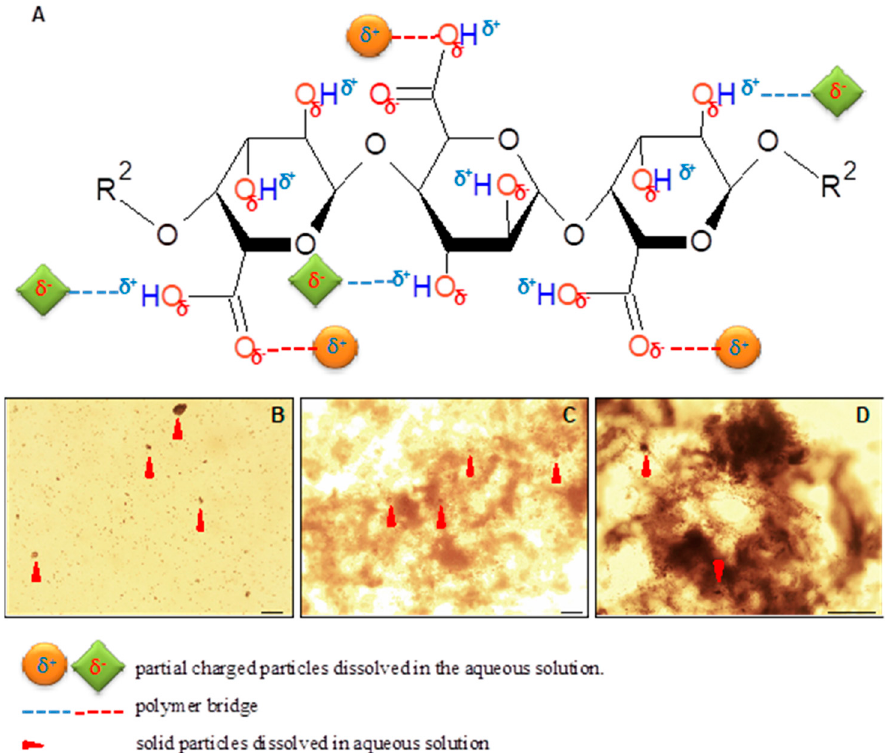
Figure 1. Supposed scheme of D-galacturonic acid ionic adsorption, pectin constituent in the mucilage of N. cochenillifera , in aqueous solution. The free − COOH and − OH groups with positive and negative partial charges adsorb and aggregate the anionic and cationic polymers dissolved in the aqueous solution by the hydrogen bonds formation ( A ). 10× aqueous solution micrographs without ( B ) and with N. cochenillifera at 10× ( C ) and 100× ( D ) forming the aggregates.